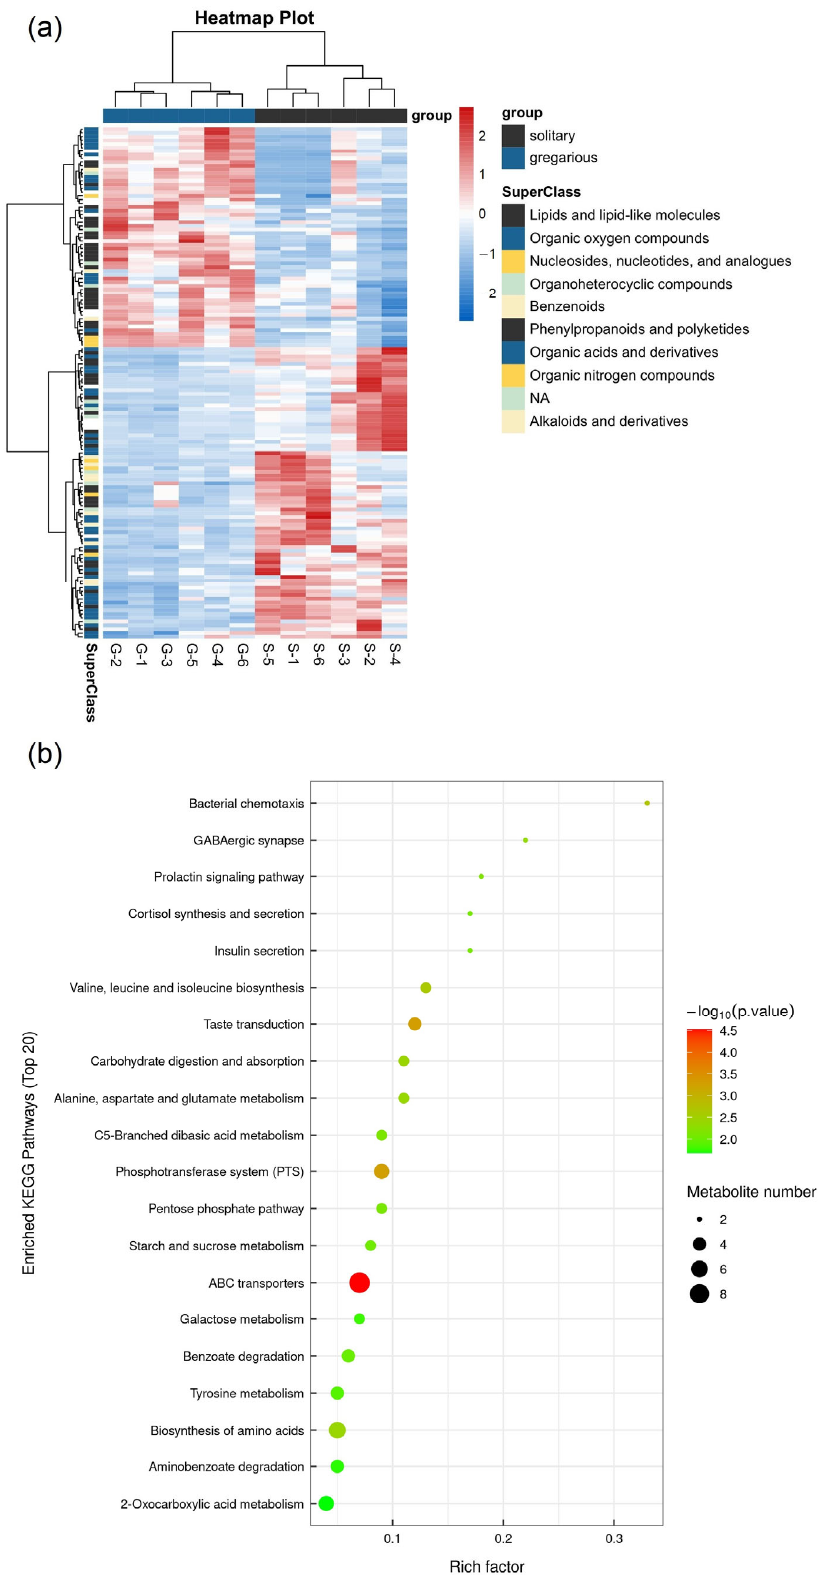
Figure 8. Analysis of differentially accumulated metabolites between gregarious and solitary second-day sixth instar oriental armyworm ( M. separata ) larvae. ( a ) Clustering heatmap: S indicates solitary type and G gregarious type. ( b ) KEGG enrichment bubble chart.